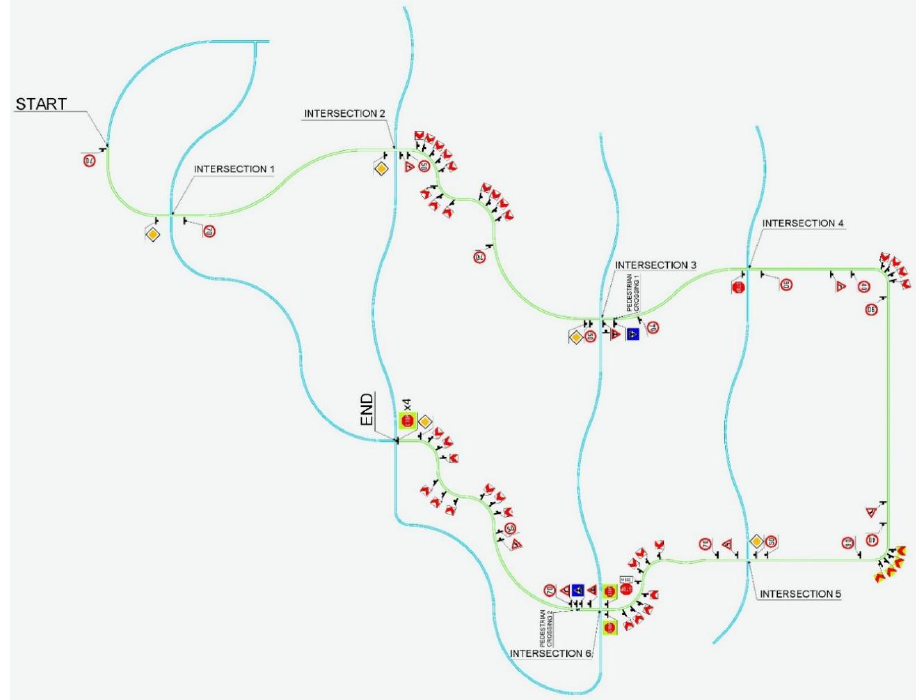
Figure 2. Representation of driving scenario (green route).